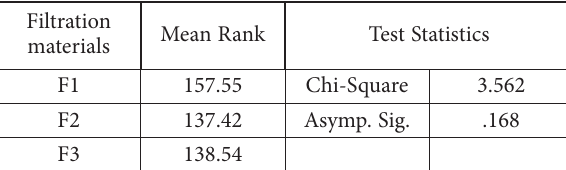
Table 10. Kruskal-Wallis rank test results of the plant height values in the experiments with different filtration materials Filtration materials Mean Rank Test Statistics